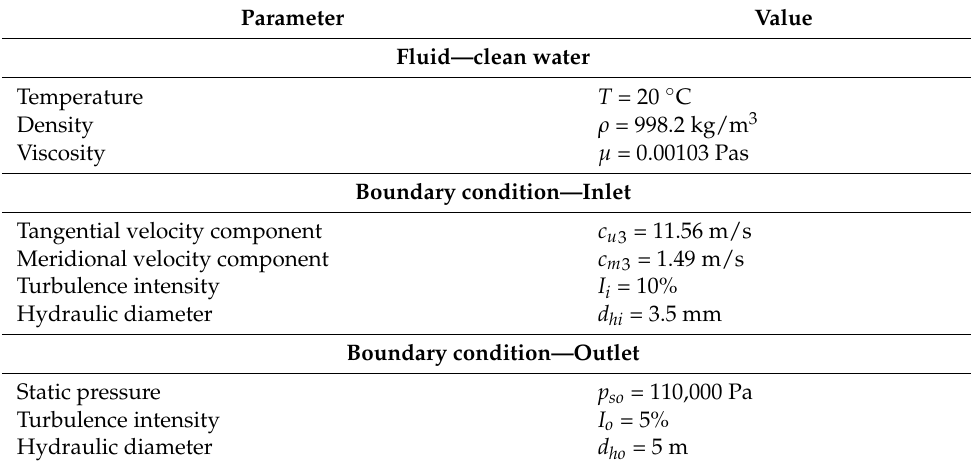
Table 6. Boundary conditions and fluid properties used in the calculations.